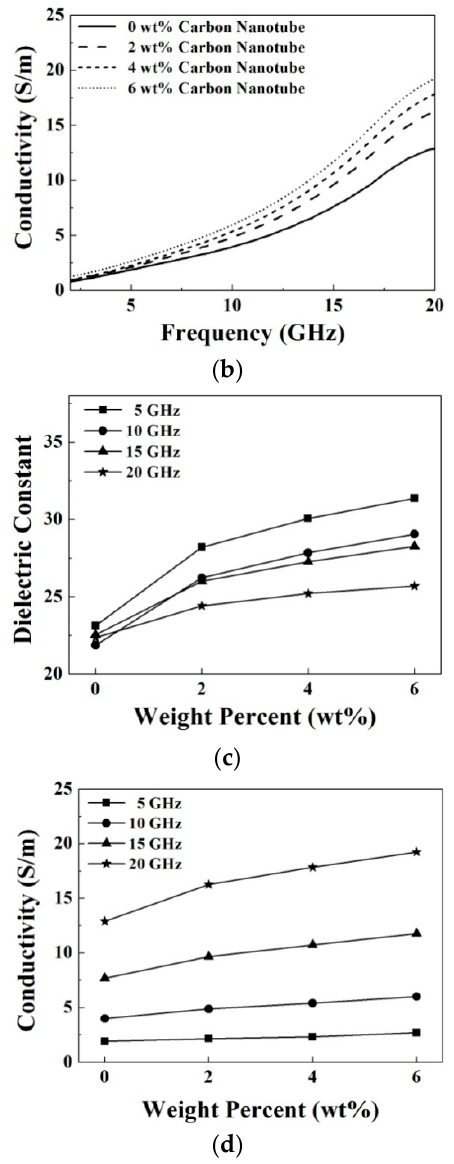
Figure 7. ( a ) Dielectric constant; ( b ) conductivity; ( c ) increment variation of the dielectric constant, and ( d ) increment variation of the conductivity of the prepared samples as functions of the doping concentrations of carbon nanotube.